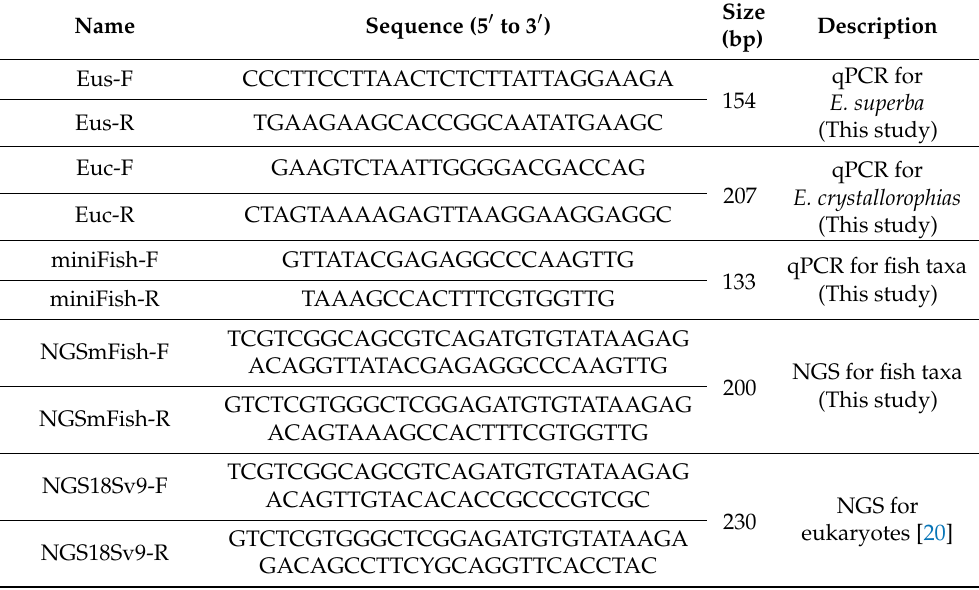
Table 2. Primers used in qPCR and NGS analysis of fecal DNA of Ad é lie penguins ( Pygoscelis adeliae